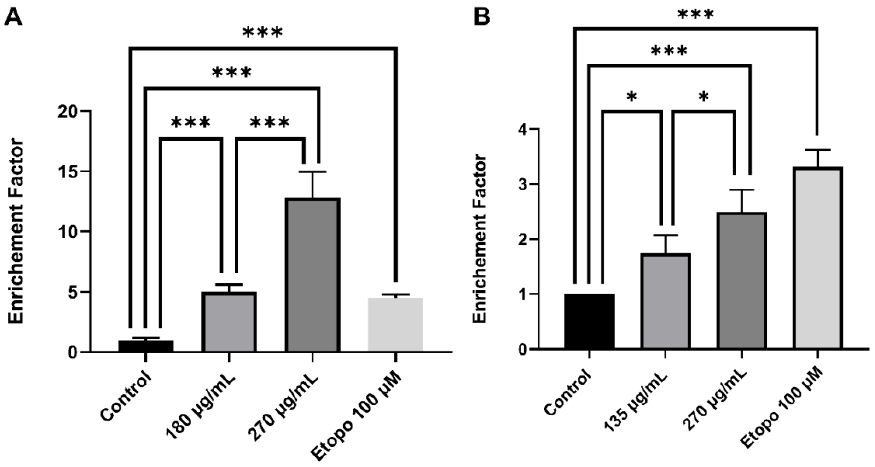
Figure 4. Cell Death ELISA on Monomac-1 ( A ) and KG-1 cells ( B ) treated with